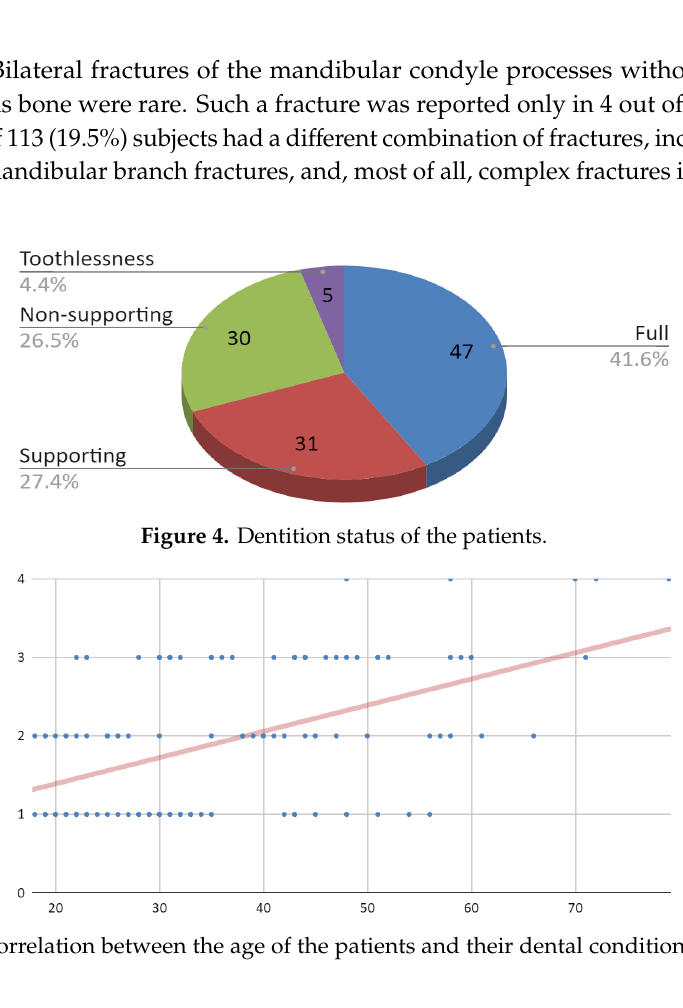
Figure 4. Dentition status of the patients.